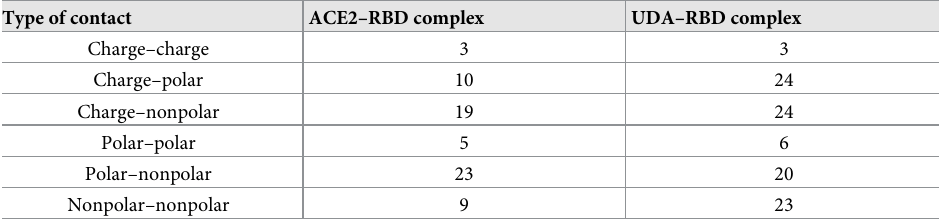
Table 2. Comparing the various types of interactions between RBD-UDA and RBD-ACE2 (PDB ID: 6glz).